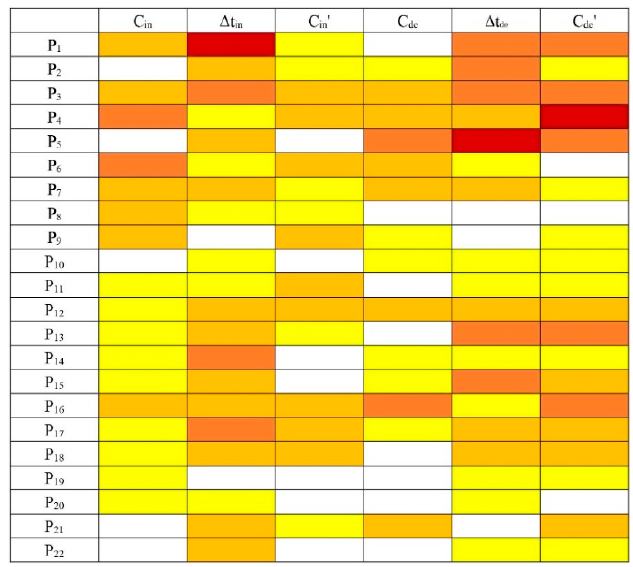
Figure 5. Frequency of principal factors that significantly influence PM 2.5 .